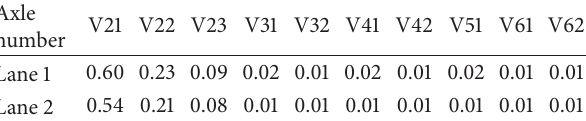
Table 7: Transverse distribution of the traffic flow.